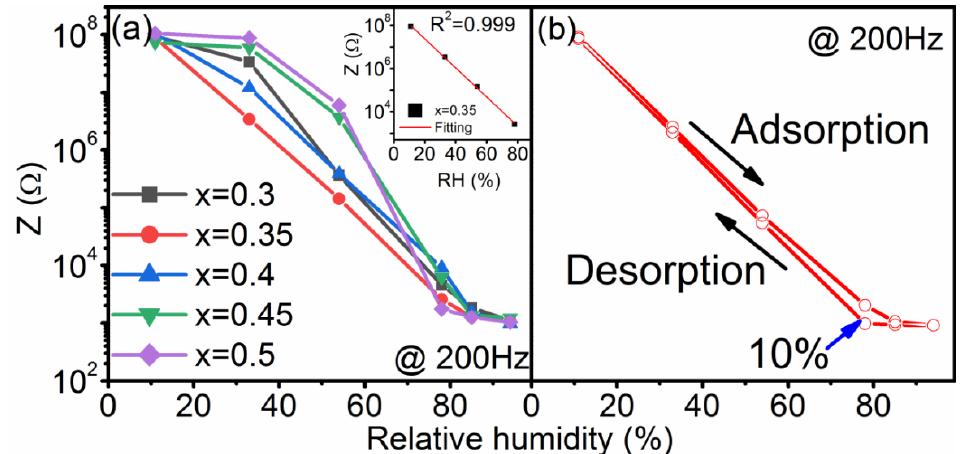
Figure 2. ( a ) Humidity sensing properties of Na 0.5 Bi x TiO 3 -based sensor recorded with 200 Hz. The inset graph shows the linear fitting of the impedance data over the humidity range of 11–75% RH for the Na 0.5 Bi 0.35 TiO 3 -based sensor. ( b ) Hysteresis behavior of the Na 0.5 Bi 0.35 TiO 3 − based sensor.